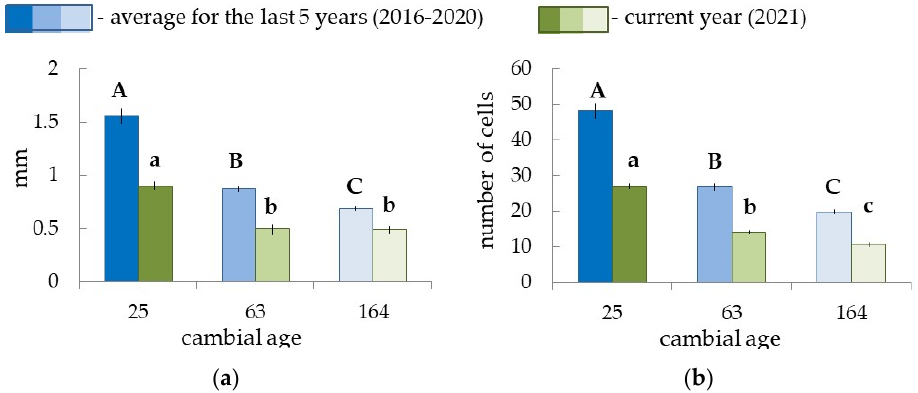
Figure 3. The width of annual xylem increment ( a ) and number of cells in the radial row of the xylem ( b ) in pine plants of different ages. The blue color—the average meanings for the last 5 years, 2016–2020 (samples were collected in May 2021) and the green color—the meanings of current year xylem (samples were collected on 21–22 June 2021). Different letters indicate significant differences at p -value ˂ 0.05. Capital letters show significant differences between average meanings for the last 5 years, lower ones—for the current year.